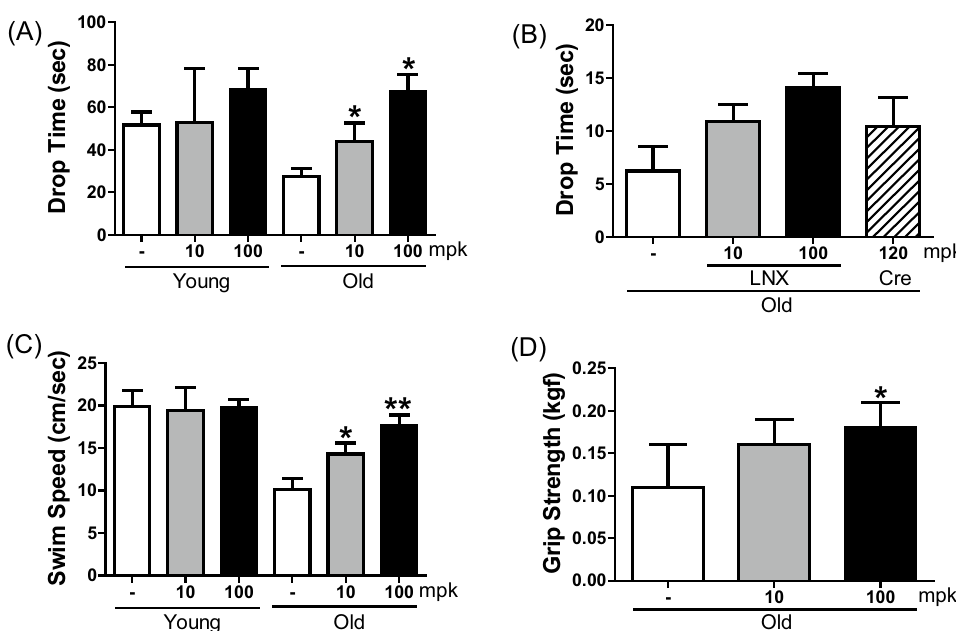
Fig. 2 Improved effects of LNX on exercise activities in LNX‑fed mice. A Rota‑rod, B wire‑hanging, C swimming, and D grip strength tests were performed in LNX‑fed mice. Data represent mean standard deviation of triple or quadruple experiments. Statistical significance * p < 0.05, ** ± p <